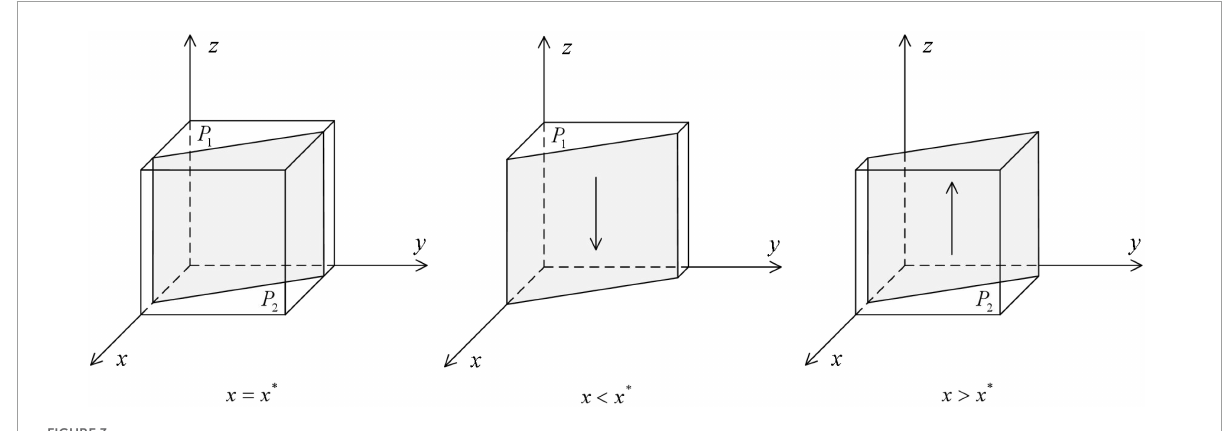
FIGURE3 Impact of changes in the probability of strategy of local government health departments on the ESS of patients.